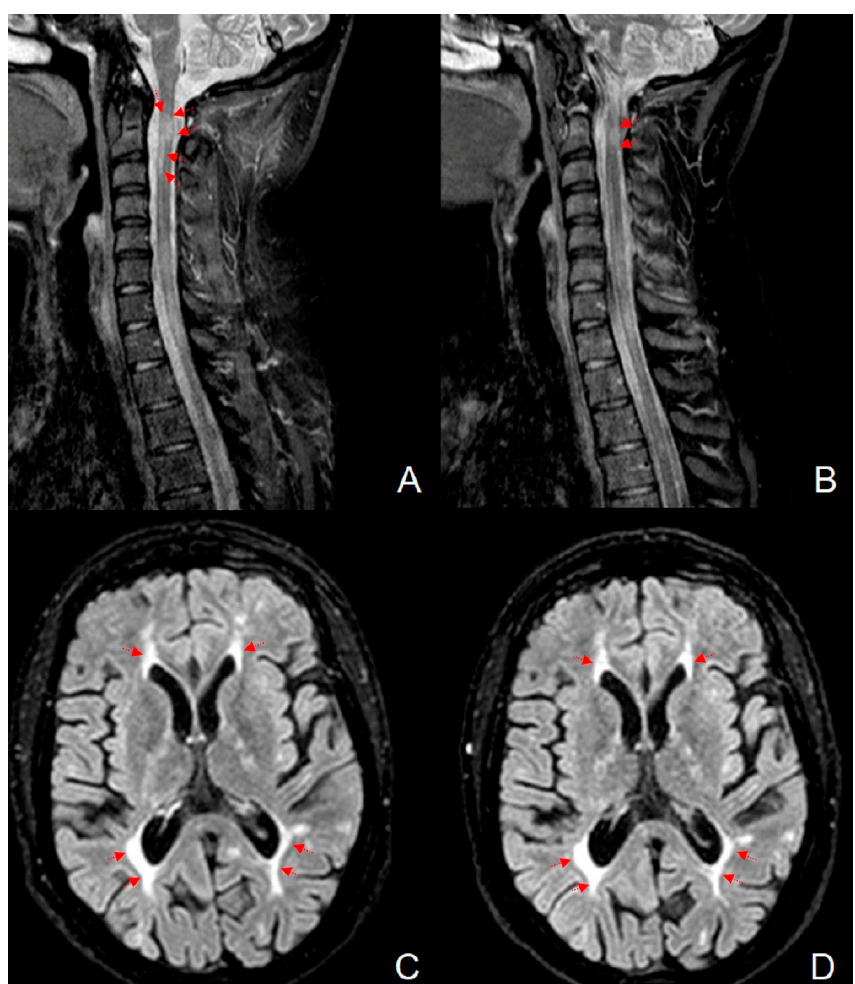
Figure 1. Magnetic resonance imaging on the short tau inversion recovery (STIR) sequence of the cervical spinal cord, affected by a demyelinating lesion at the second and third metamer before ( A ) and after ( B ) DFPP treatment. Note the reduction in the size of the lesion in comparison to the pre-treatment image. Axial brain magnetic resonance imaging on the fluid attenuated inversion recovery (FLAIR) sequence shows the periventricular lesion load before ( C ) and after ( D ) DFPP treatment. Red arrows evidence the brain and spinal cord lesions.